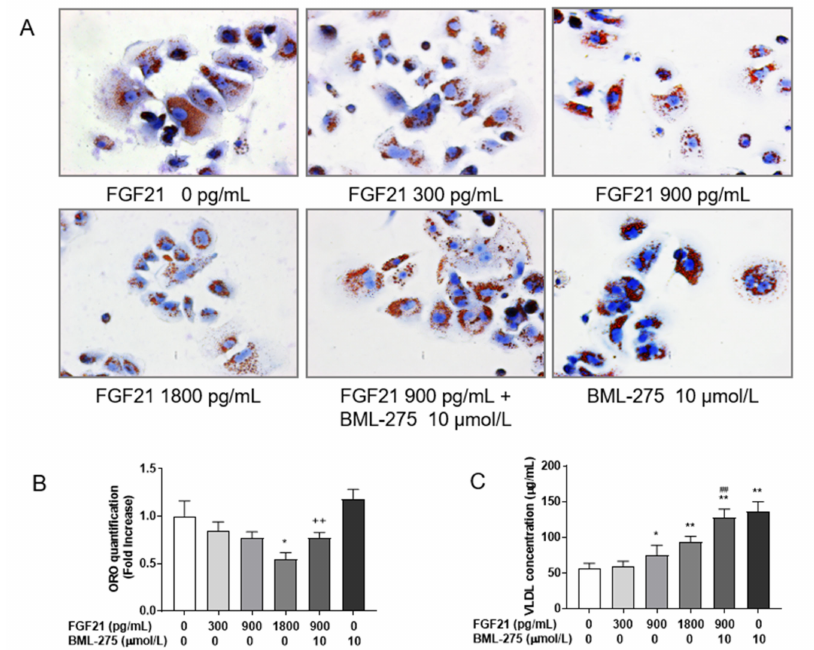
Figure 6. FGF21 decreases ORO staining area and increases the secretion of VLDL in hepatocytes. ( A ) Oil red staining of hepatocytes treated with FGF21 and BML-275 individually or in combination for 4 h (400 × ). ( B ) Quantitative analysis after ORO staining from 4 randomly selected images, normalized by the control group. ( C ) The content of cell supernatant VLDL was detected after treated with FGF21 and BML-275 individually or in combination for 4 h. Statistical significance was indicated: *, p < 0.05; **, ++ and ## , p < 0.01; * was compared with control group, # was compared with 900 pg/mL group, + was compared with BML-275